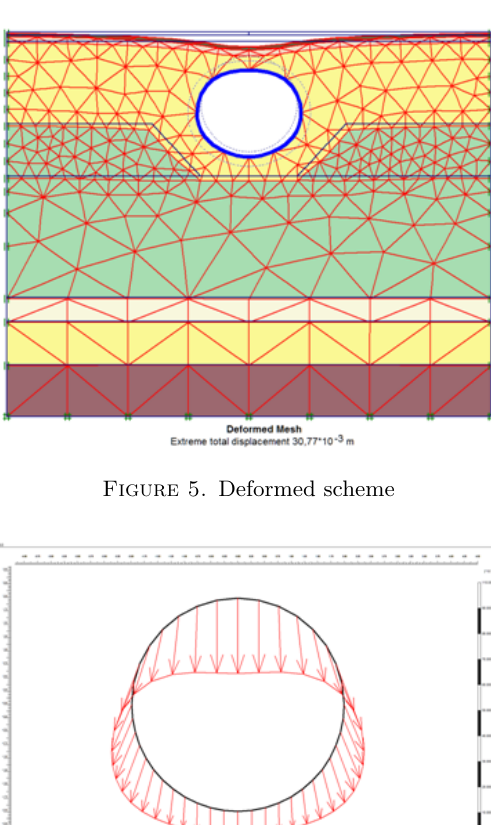
Figure 8. The diagram of bending moment for sand backfill ( M max = 6 . 5 kNm)